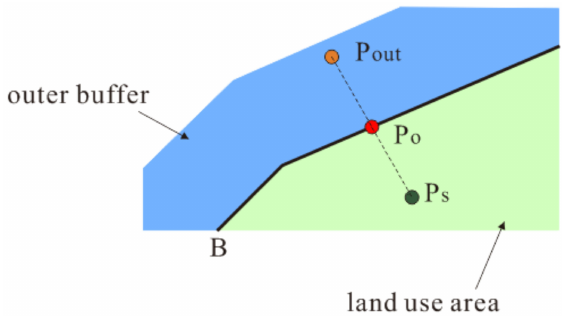
Figure 6. Schematic diagram of symbol point shift under the outer buffer constraint.